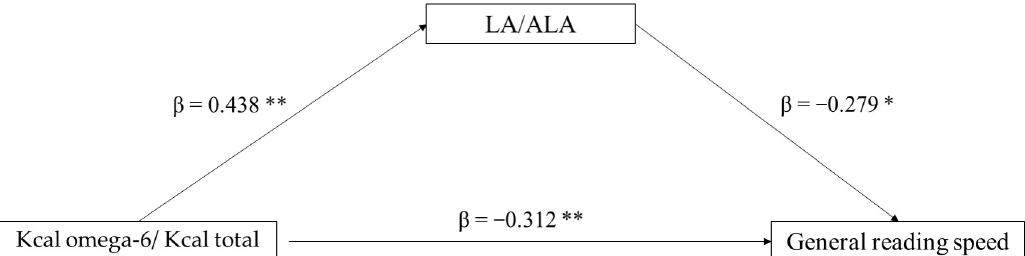
omega-6/Kcal total as the independent variable, and LA/ALA ratio as mediator (* p < 0.10, ** p < 0.05,